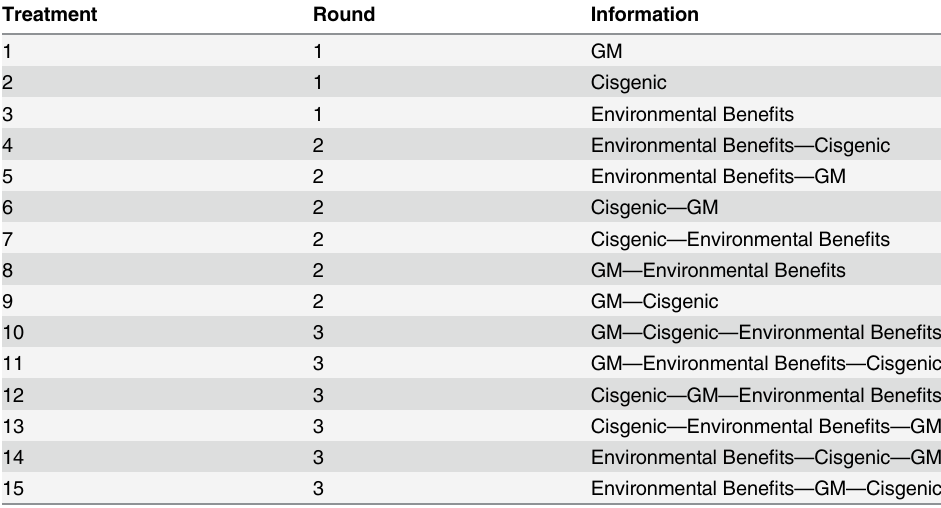
Table 3. Ordering of information treatments for Variety A. Treatment